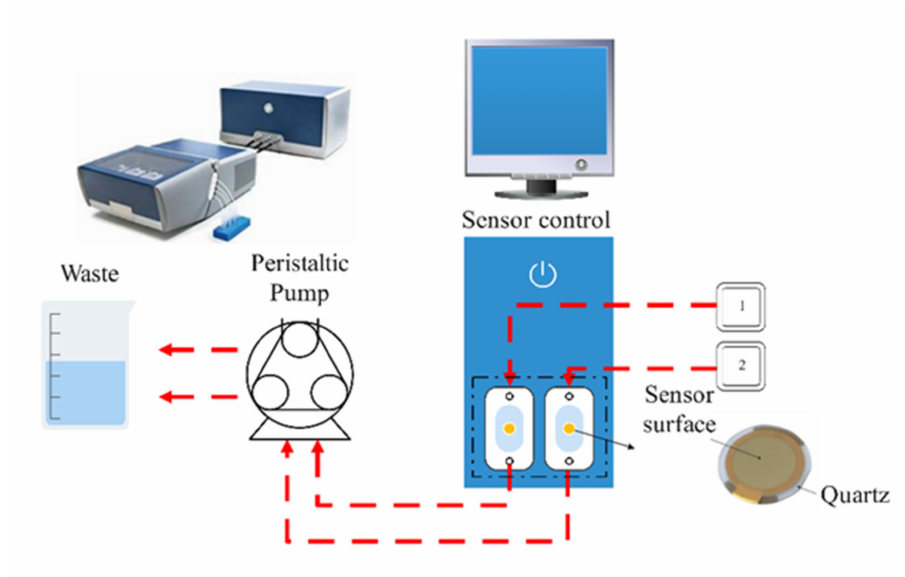
Figure 6. QCM-D instrumental